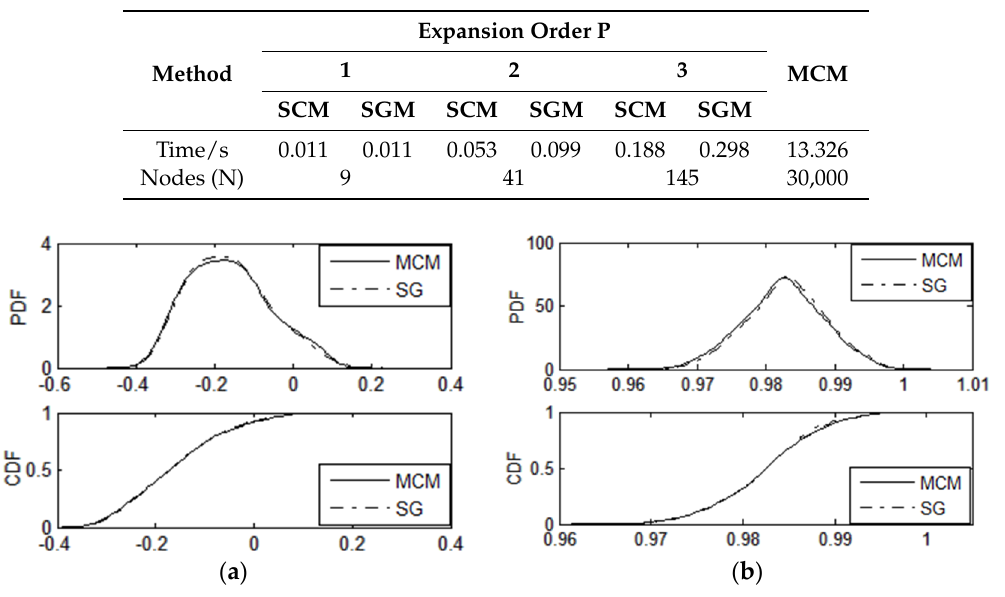
Table 3. Computation time comparison.